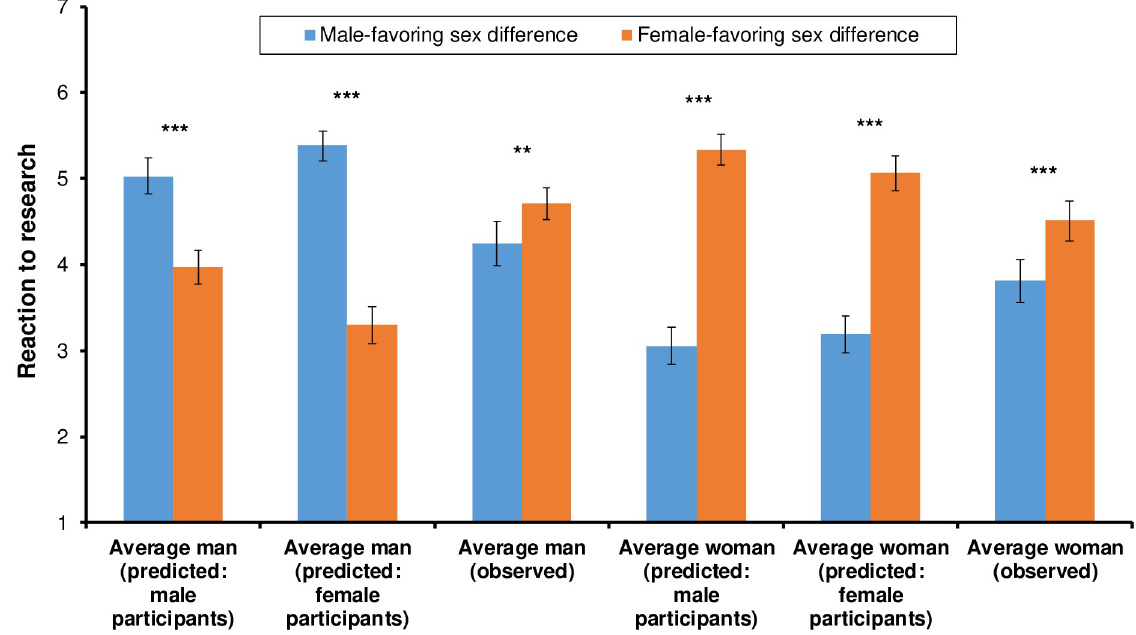
Fig 2. Participants’ predictions regarding the reactions of the average man and woman to a male- vs. female-favoring sex difference, alongside the actual reactions observed in the study. � p < .05; �� p < .01; ��� p < .001; n.s.: not significant. Error bars = 95% CIs.